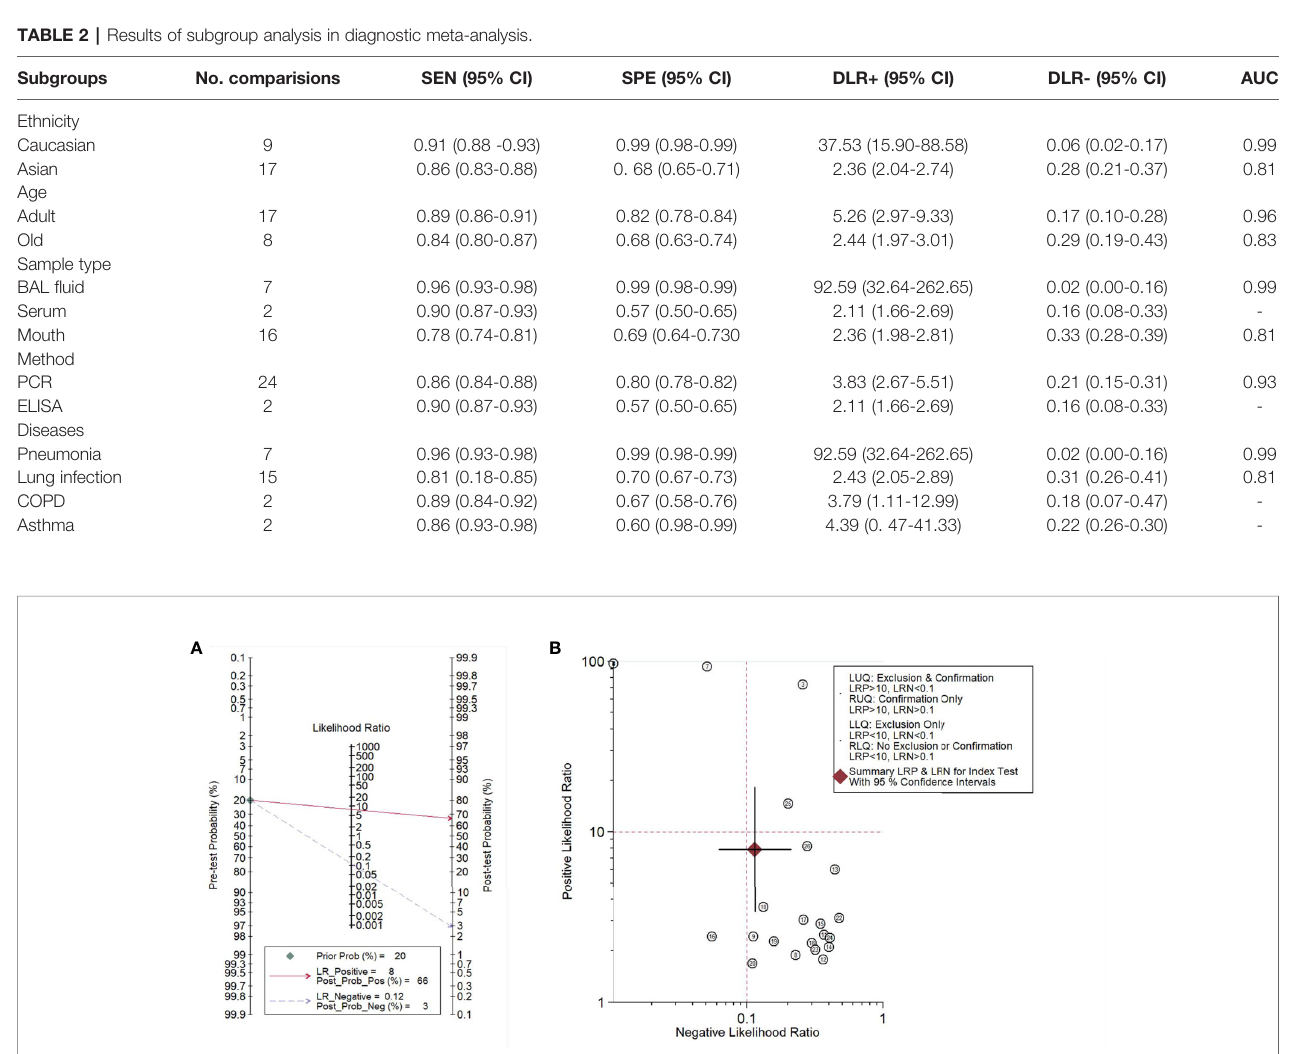
FIGURE 5 | Fagan ’ s nomogram assessing (A) and dot plot of negative likelihood ratio (B) of microbiota biomarkers for the diagnosis of lung